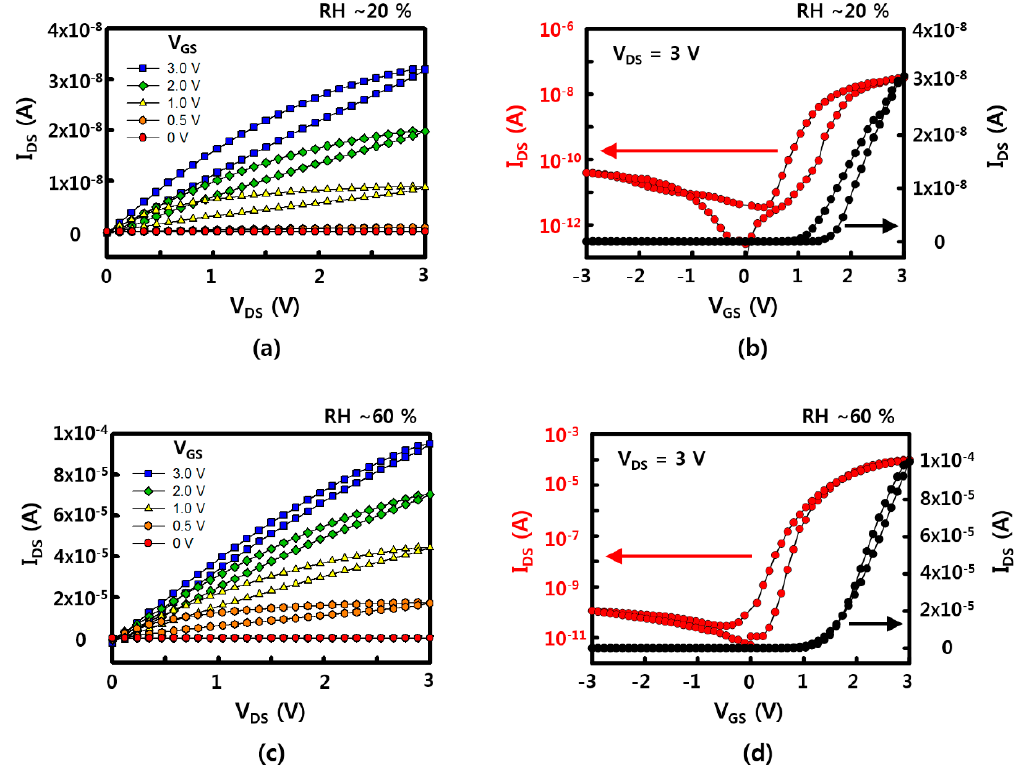
Figure 2. Electrical properties of a SnO 2 NW FET device: ( a , c ) the drain-source current (I DS )–drain-source voltage (V DS ) curve with variation of gate-source voltage (V GS ) with a relative humidity (RH) of ~20% and ~60%, respectively; ( b , d ) the transfer curve of I DS -V GS at V DS = 3 V with a RH of ~20% and ~60%, respectively.